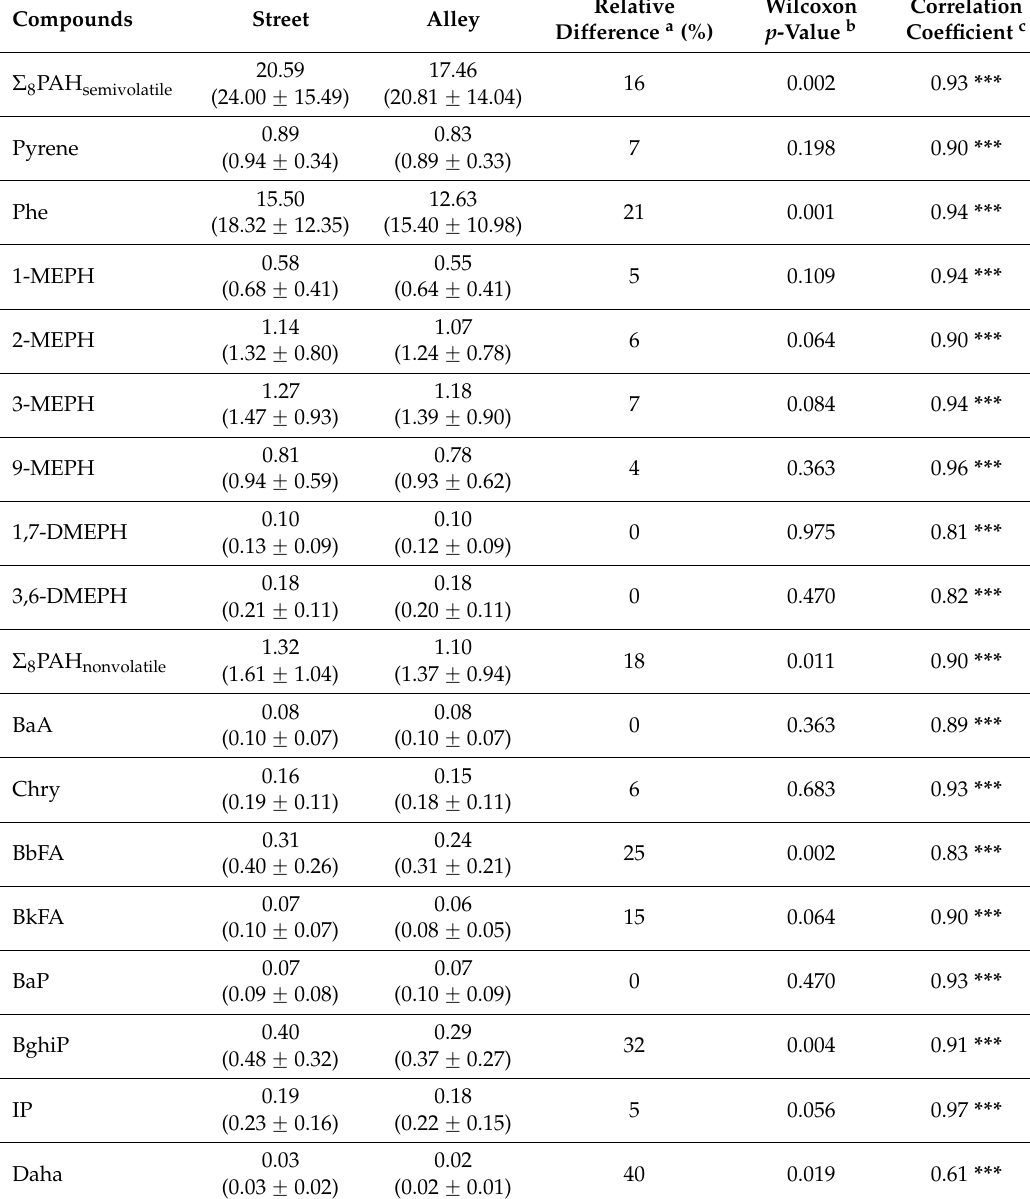
Table 2. Comparison of central site PAH concentrations between street and alley sides of the building for n = 14 two-week sampling